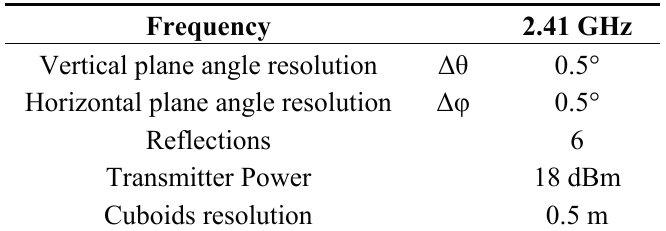
Table 2. Parameters in the ray launching simulation.